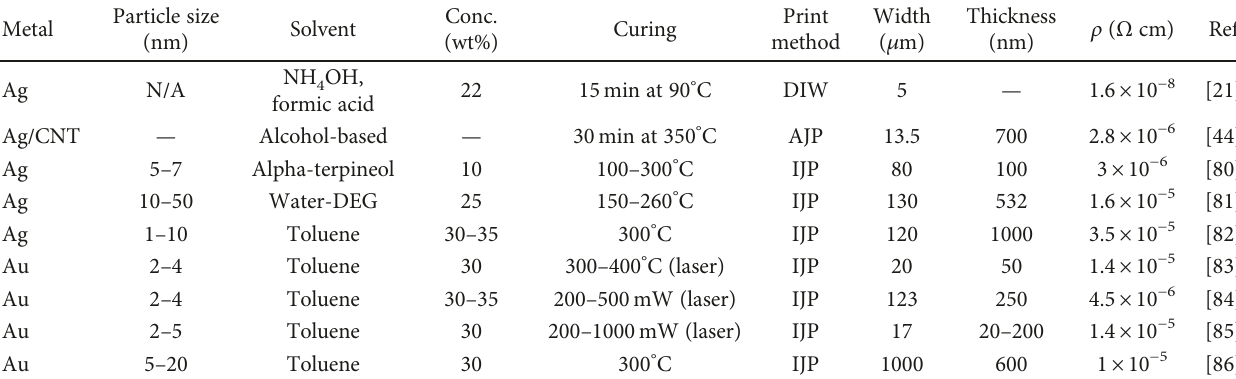
Table 3: Summary of prior work on metallic nanoparticle conductive